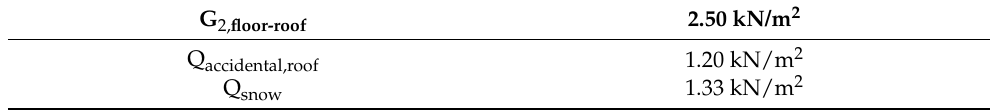
Table 2. Loads applied to the one-floor case studies (from 1 to 4).